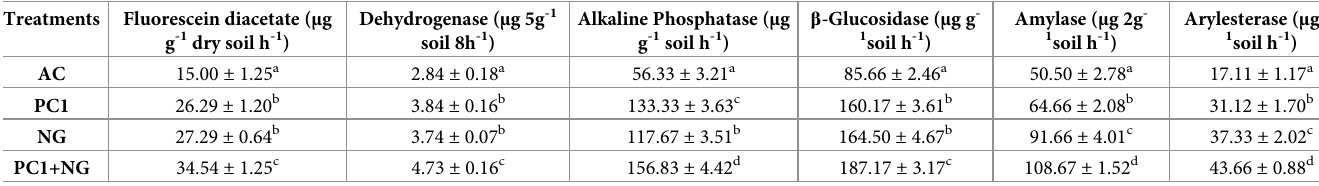
Means in each column followed by the same letter were not significantly different (P � 0.05) as determined by one-way ANOVA and Duncan’s Multiple Range Test (DMRT). Values were the means of three replications ±